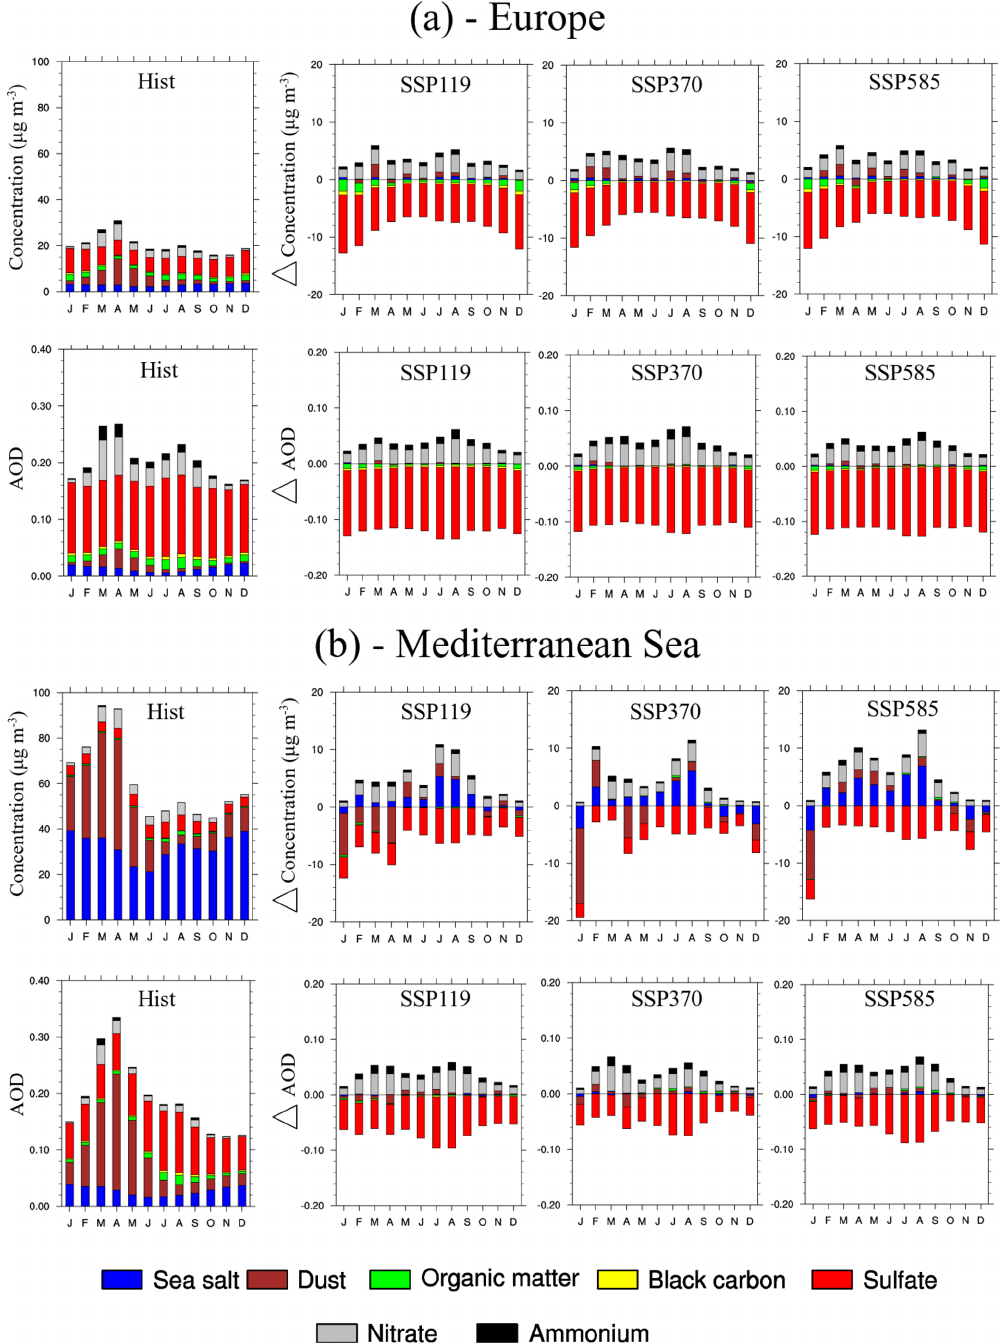
Figure 5. Surface concentration (µgm − 3 ) and AOD evolution of the different aerosols between the past period (1971–2000) and the future period (2021–2050) according to SSP 1-1.9, SSP 3-7.0 and SSP 5-8.5 over Europe (a) and the Mediterranean Sea (b)